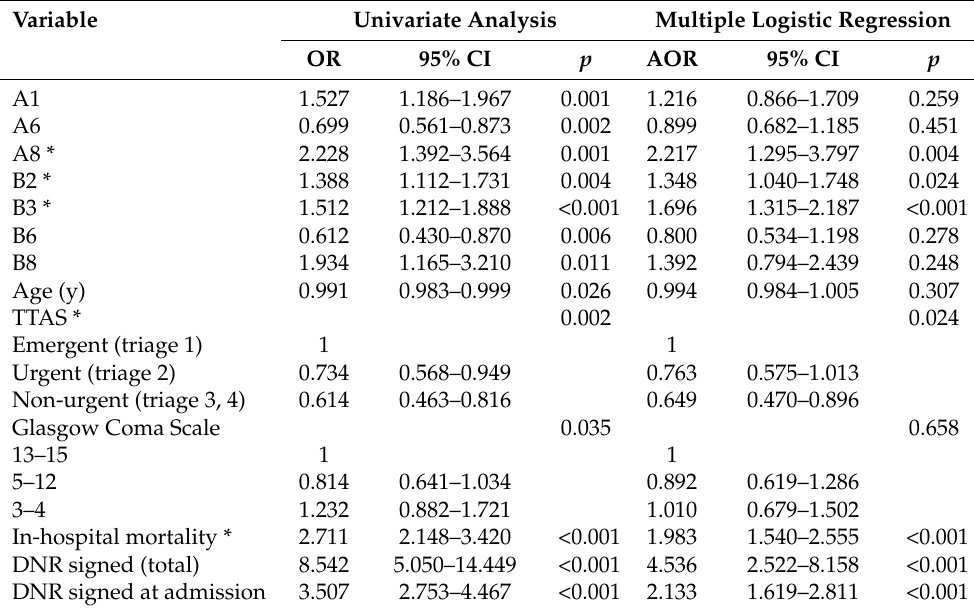
Table 3. Univariate and multiple logistic regression analysis of clinical characteristics between patients with ED-PC and